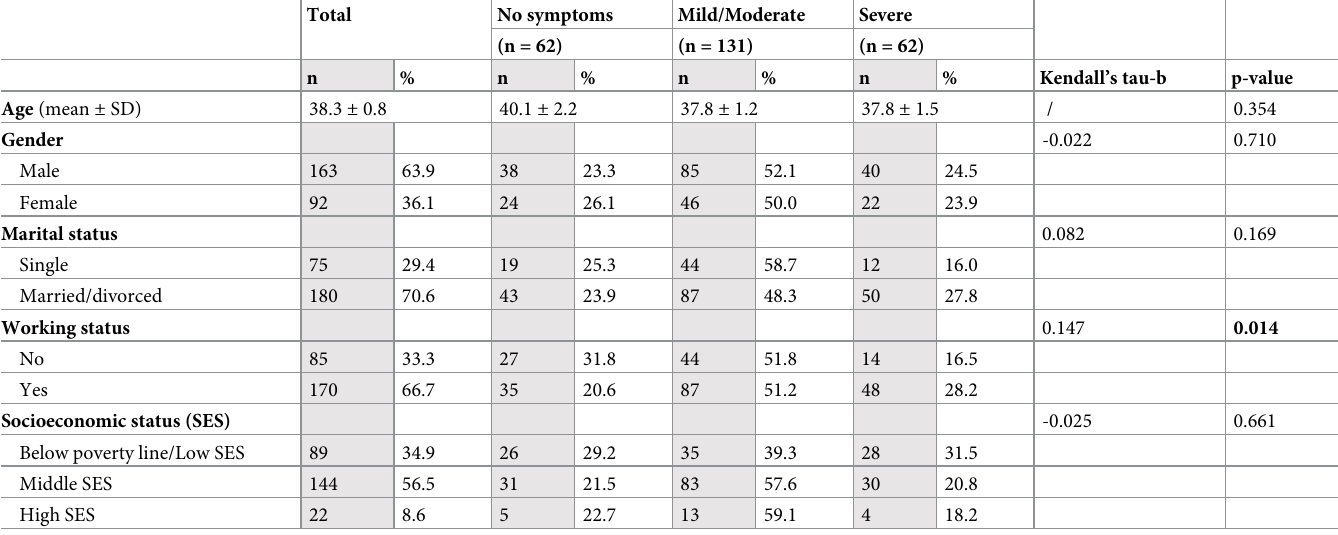
Data are presented as mean ± SD for the continuous variable age and as frequency and percentage for categorical